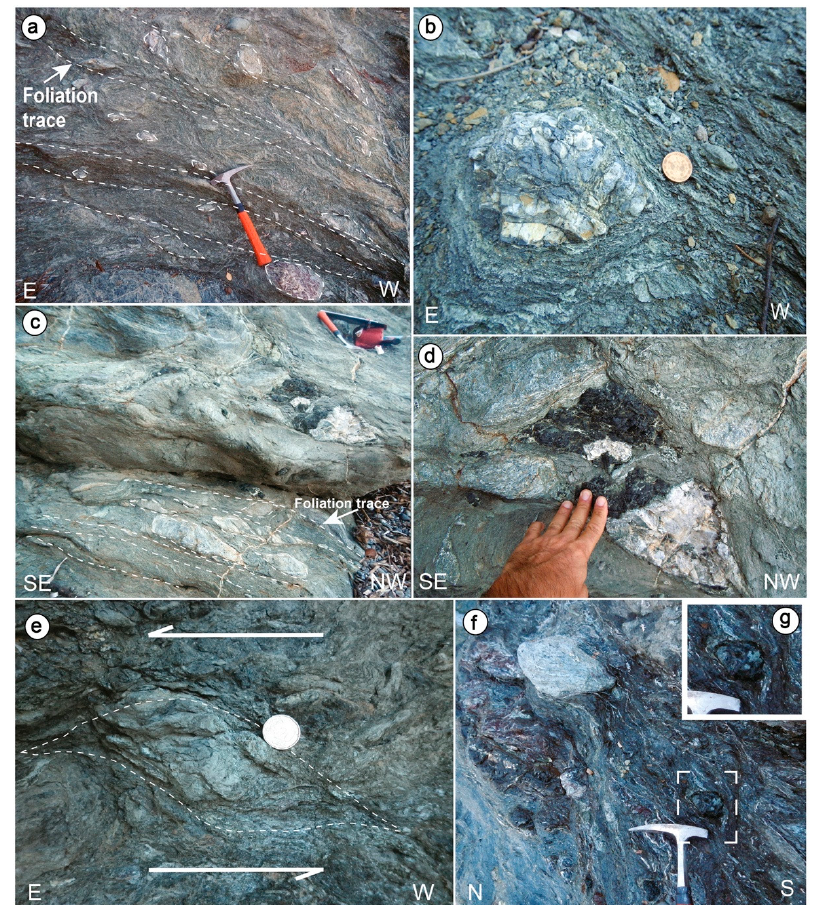
Figure 7. Mylonitic domain in serpentinite rocks. ( a – c ) well expressed schistosity, in crystallized matrix with large porphyroclasts (predominantly of carbonate composition), aligned along the main foliation; ( d , e ) top-to-the-east carbonate and ultramafic porhyroclasts; ( f ) top-to-the-east δ -type ultramafic (enlarged in g) and carbonate porphyroclasts.